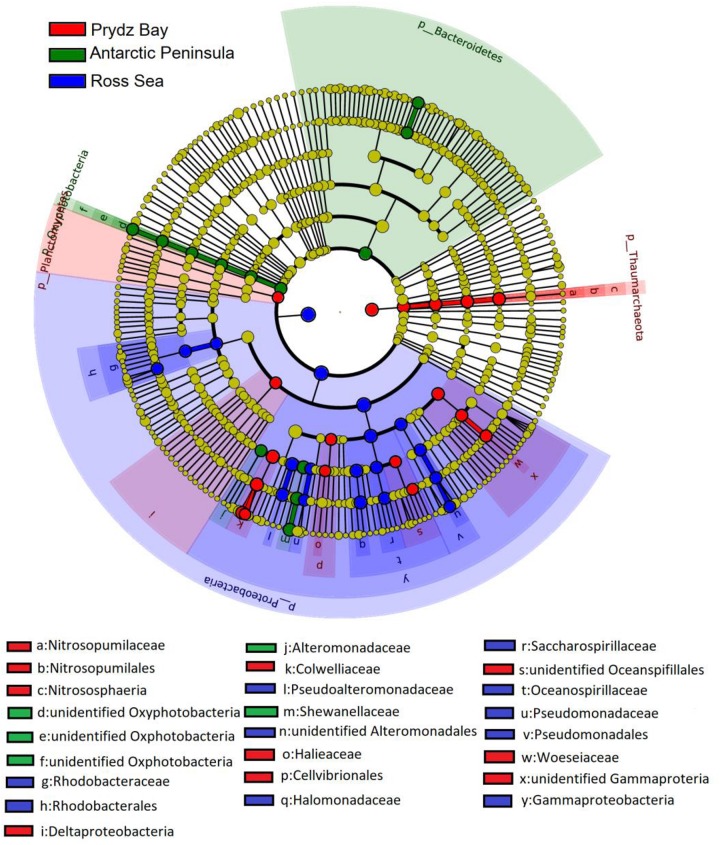
Identification of the distinct bacterial taxa from different sampling regions using LEfSe. Only bacterial taxa with LDA values greater than 4 are displayed in this cladogram. Differences in the most abundant taxa are represented by colors (red, green, and blue indicate Prydz Bay, the Antarctic Peninsula region, and the Ross Sea, respectively). The diameter of each circle is proportional to the corresponding taxon’s abundance. Circles represent phylogenetic levels from phylum to genus. Labels are shown from phylum to genus level.